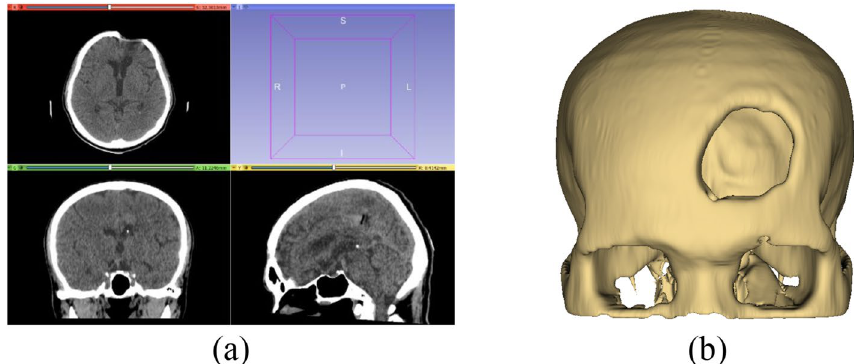
Figure 4. Mirror based modelling ( a ) import DICOM data and ( b ) reconstruct 3D model.